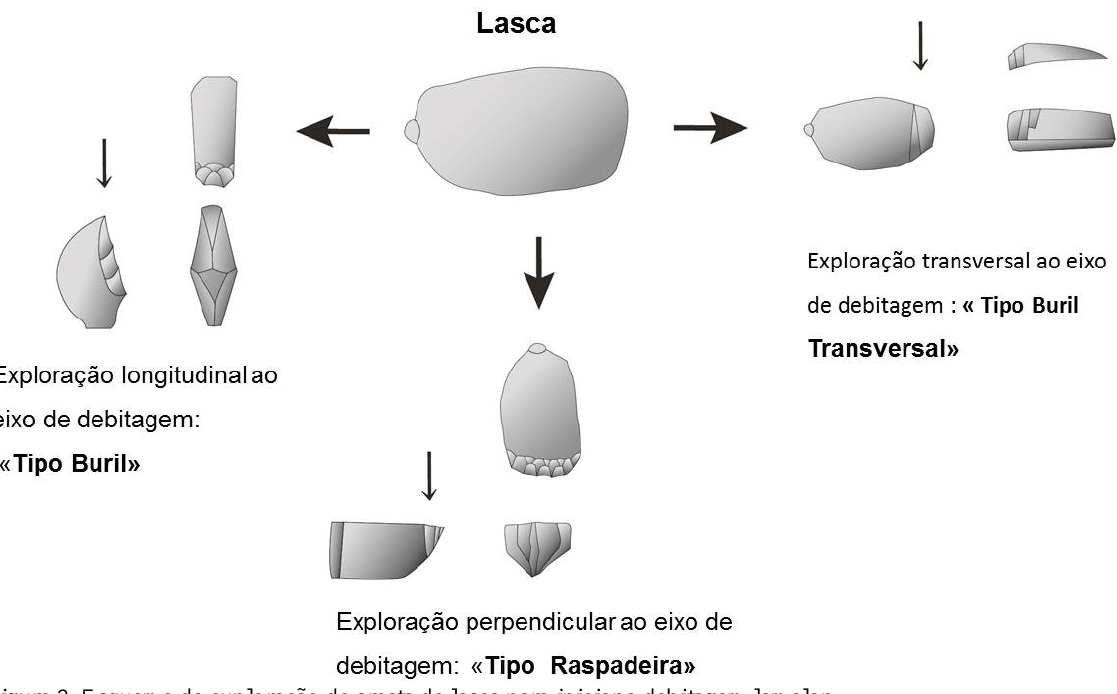
Figura 2. Esquema de exploração de aresta de lasca para iniciar a debitagem lamelar. Figure 2. Schematic drawing showing exploitation of the flake edge to start bladelet